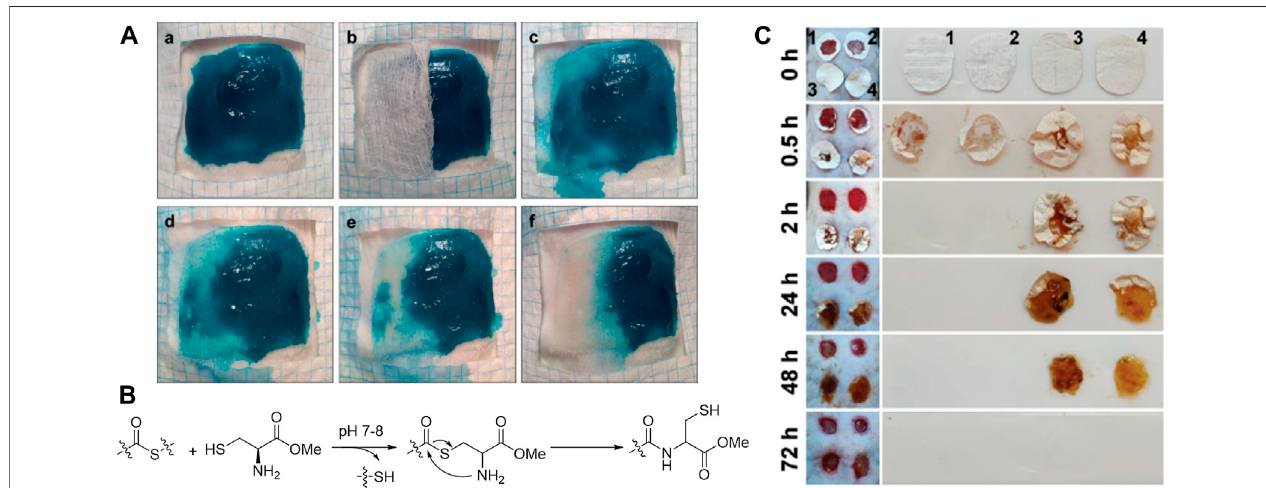
FIGURE 4 | (A) Dissolution of the hydrogel after treatment with an aqueous cysteine methyl ester (CME) solution (0.3 m, pH 8.6) via thiol – thioester exchange (B) (Konieczynska et al., 2016). Images were adapted with permission from Konieczynska et al. (2016). Copyright 2016, John Wiley and Sons. (C) Degradation of different nano fi broushydrogel(1FHHA,2FHHA-S,3FHHA/Fe,and4FHHA-S/Fe)(Liuetal.,2020a).CrosslinkingwithFe 3+ increasedthe invivo stabilityofhydrogel.FHHA,high molecular weight HA fi bers; FHHA-S, thioether grafted high molecular weight HA fi bers; FHHA/Fe, Fe 3+ crosslinked high molecular weight HA nano fi brous hydrogel; FHHA-S/Fe, Fe 3+ crosslinked thioether grafted high molecular weight HA nano fi brous hydrogel. Images were adapted with permission from Liu et al. (2020a). Copyright 2020, John Wiley and Sons.